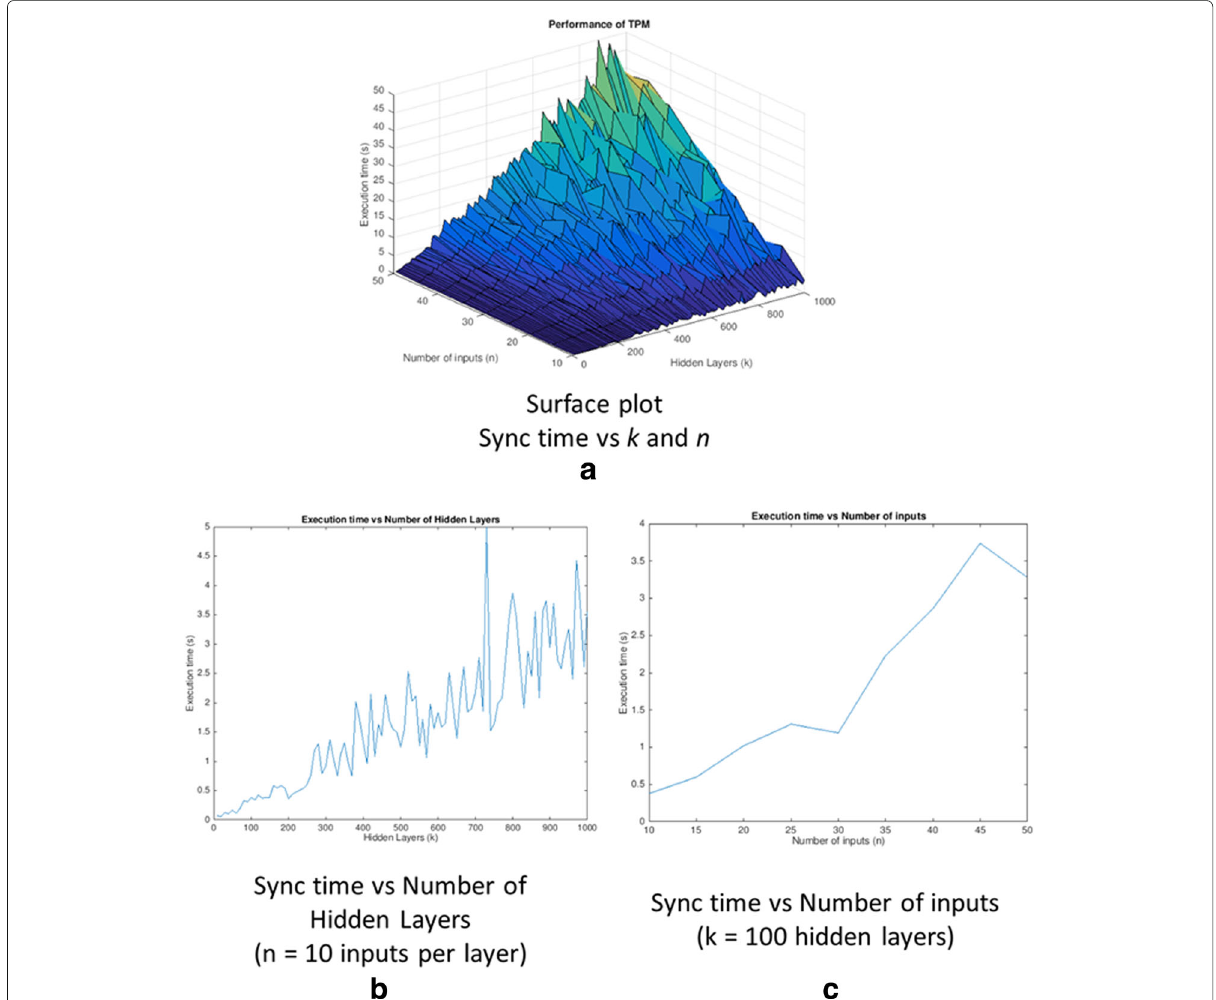
Fig. 6 TPM performance evaluation. a Surface plot with varying hidden layers and varying number of inputs. b Execution time with varying number of hidden layers and c with varying number of inputs